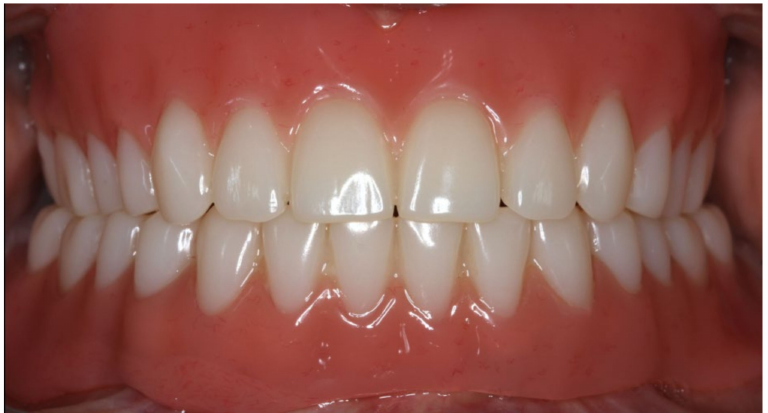
Figure 21. Anterior view of the inserted dentures in centric